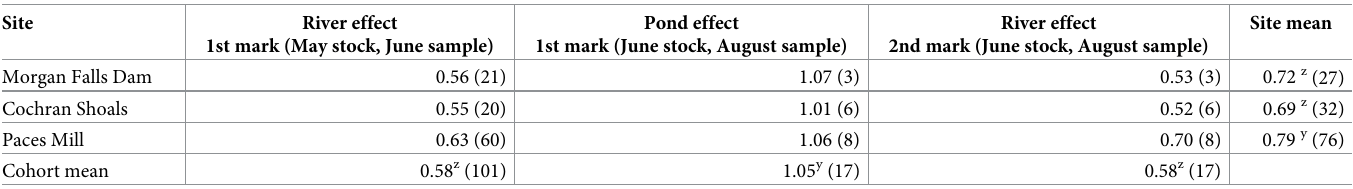
Table 3. Mean proportional distance of 10 daily rings post-OTC mark compared to 10 daily rings pre-OTC mark for Shoal Bass ( N ) reared in hatchery ponds and stocked at three sites in the Chattahoochee River,